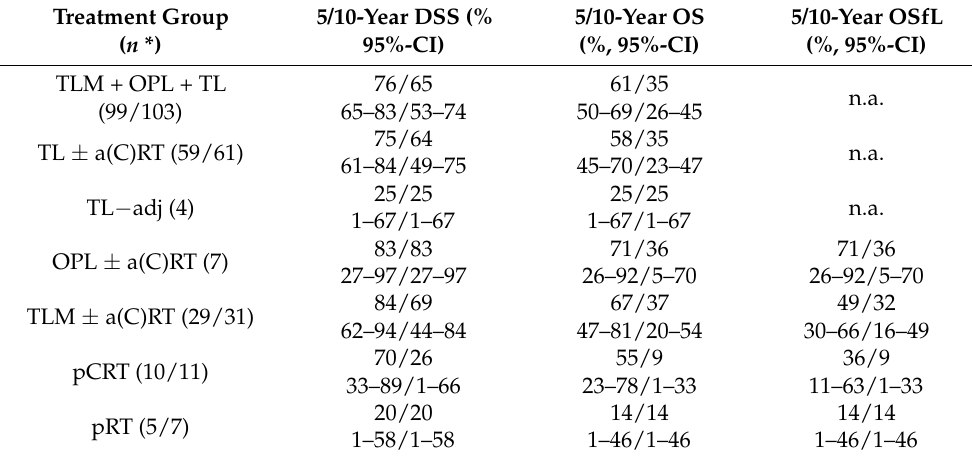
Table 3. DSS, OS, and OSfL after 5 and 10 years of T3 patients in the different treatment arms. Treatment Group